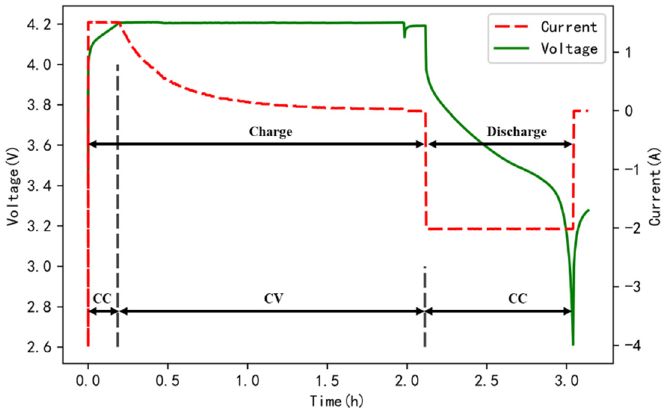
Figure 2. Charge and discharge process in the first cycle of the B5 battery.